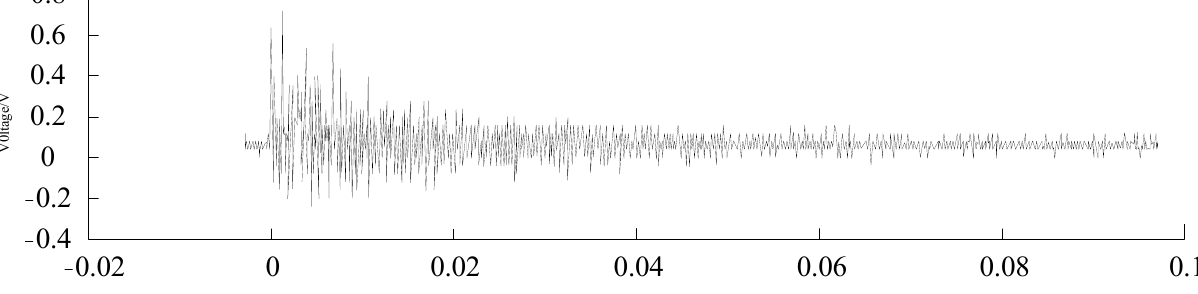
Figure 8. Corn kernel impacting signal after filtering with a cutoff frequency of 8.7